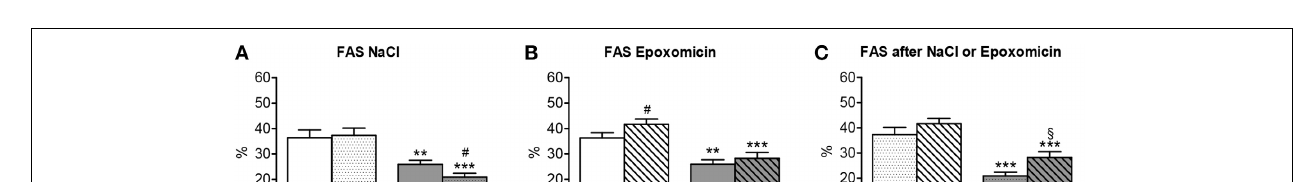
(HW/BW) and heart-weight-to-tibia-length ratio (HW/TL). (C ) mRNA levels of hypertrophymarkersdeterminedbyRT-qPCRwithSYBRGreenandnormalized to Gnas . Data are expressed as mean ± s.e.m. with ∗∗ P < 0 . 01 and ∗∗∗ P < 0 . 001 vs. WT in the same condition, Two-Way ANOVA plus Bonferroni’s post-test. The number of animals is indicated in the bars. Abbreviations: Acta1 , α -skeletal actin; Nppa , atrial natriuretic peptide.